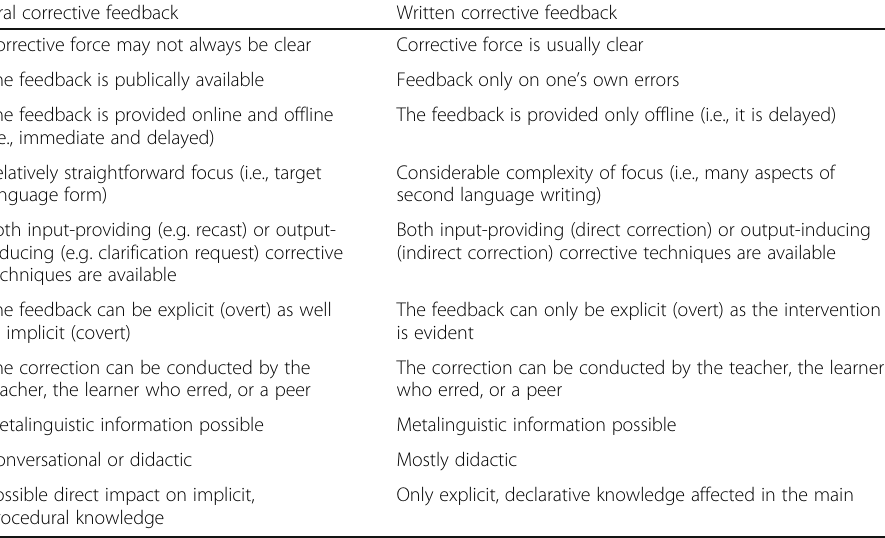
Table 2 Key differences between oral and written corrective feedback (Adapted from Pawlak, 2014) Oral corrective